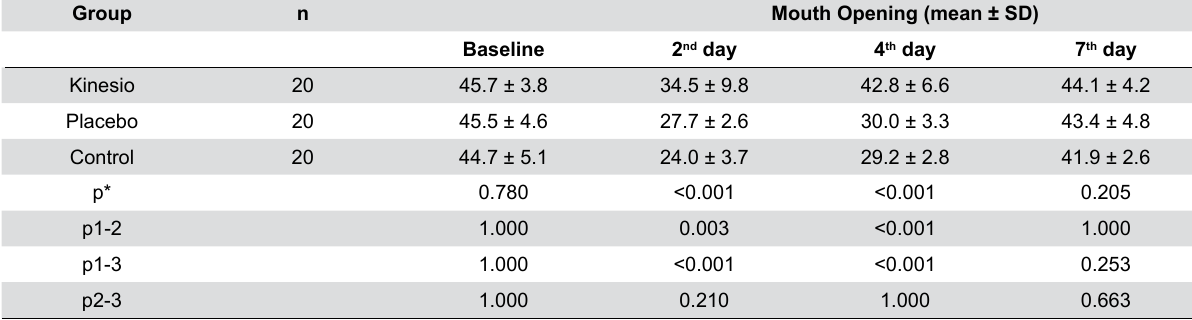
r-VAS, visual analog score at resting state; c-VAS, visual analog score at chewing state. For description of p-values, please see footnote of Table 2. Table 4- Comparison of mouth-opening values (mm) among the patients of the three